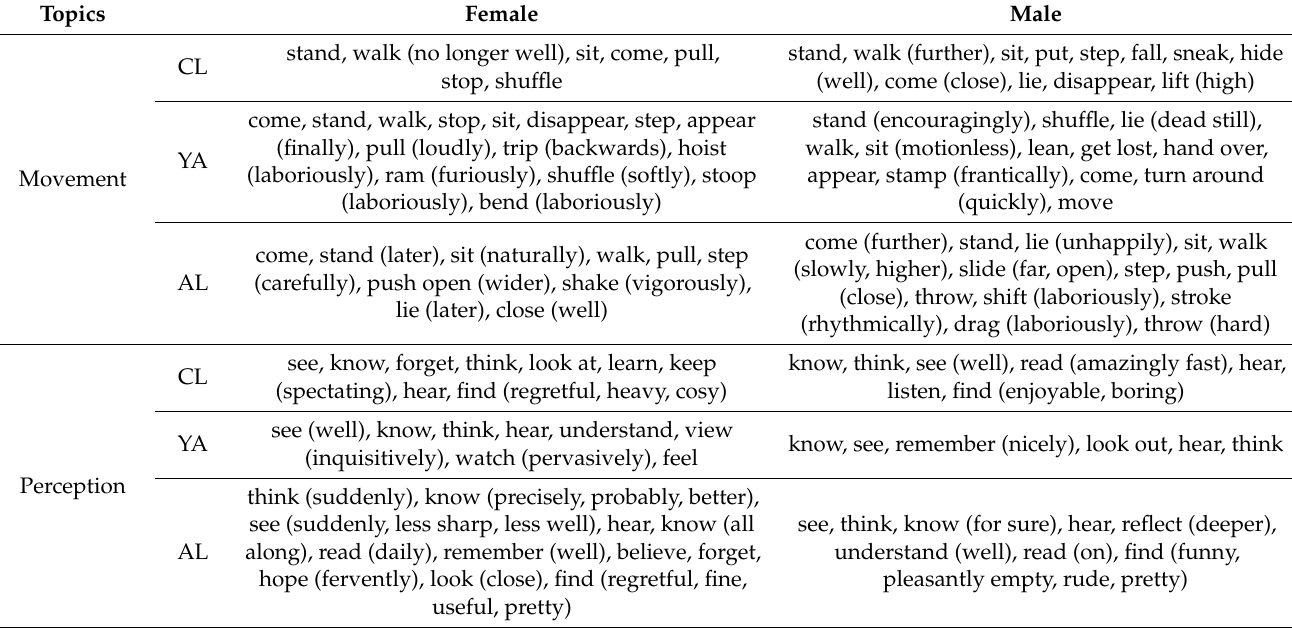
Table A2. Word lists of actions of female and male older adult characters in children’s literature